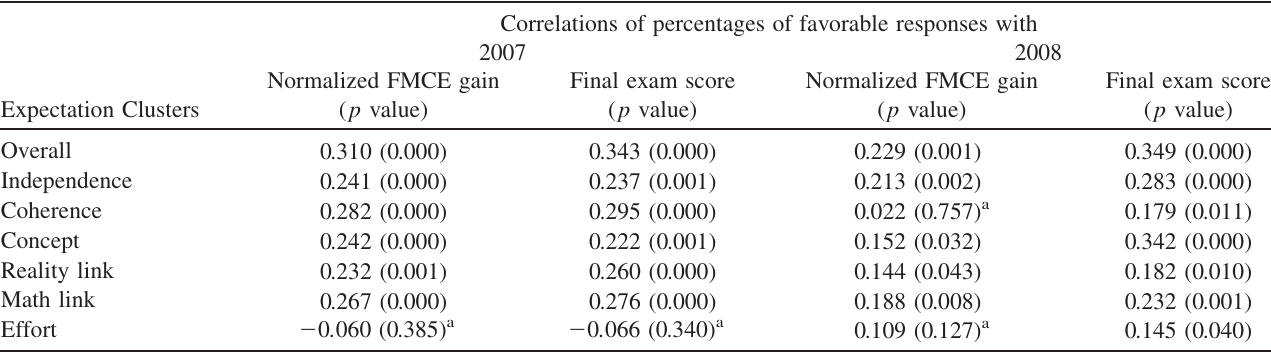
TABLE III. Pearson-r correlation coefficients between students’ percentages of favorable responses (precourse MPEX scores) and